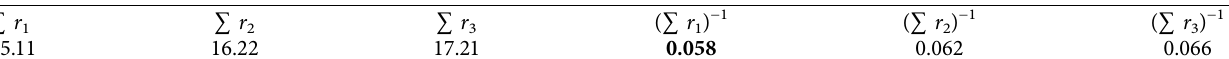
Table 12: Sum of r i and their inverse values.